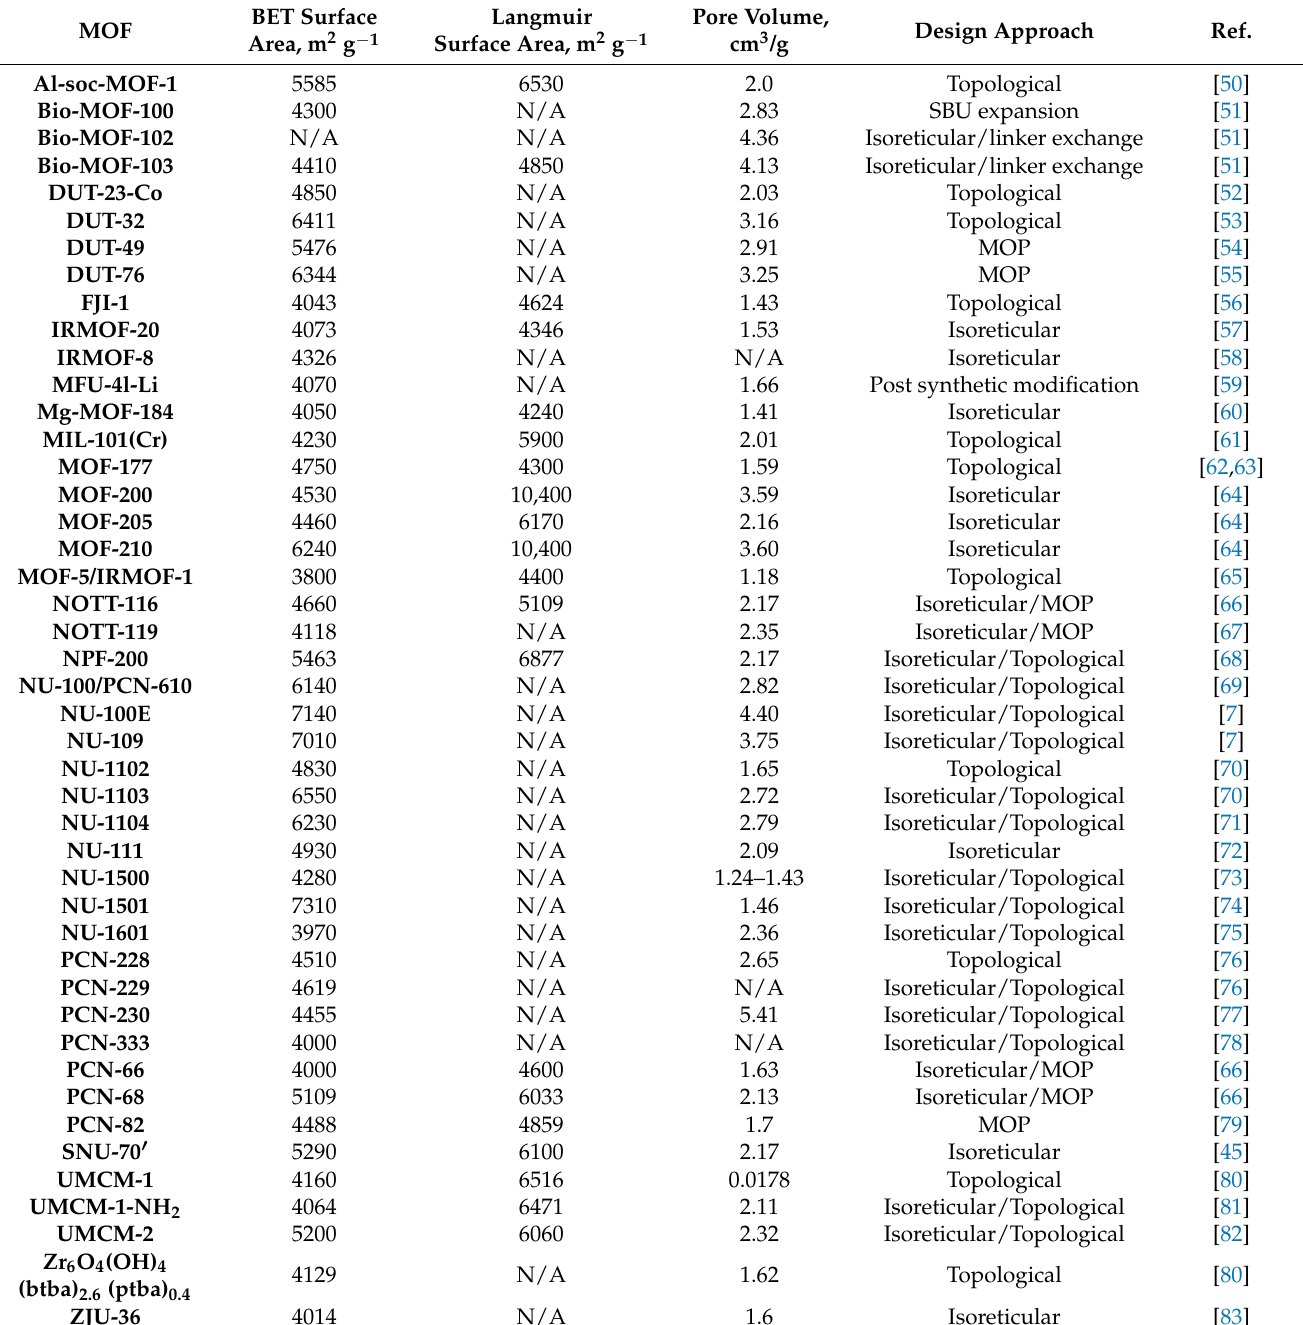
Table 1. Surface area, pore volume and design approach for HPMOFs (btab = 4,4 (cid:48) ,4 (cid:48)(cid:48) ,4 (cid:48)(cid:48)(cid:48) -([1,1 (cid:48) - biphenyl]-3,3 (cid:48) ,5,5 (cid:48) -tetrayltetrakis(ethyne-2,1-diyl)) tetrabenzoate and pteb = 4,4 (cid:48) ,4 (cid:48)(cid:48) ,4 (cid:48)(cid:48)(cid:48)